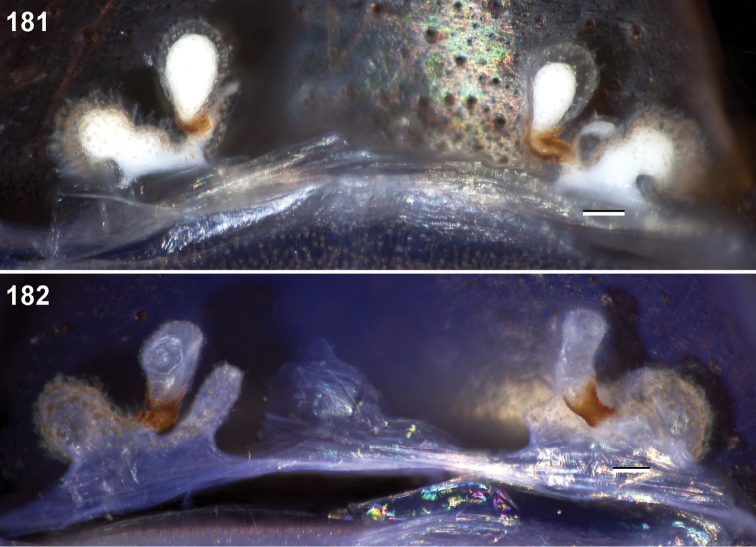
Aptostichus barackobamai sp. n. cleared spermathecae; scale bars = 0.1mm. 181 paratype from Mendocino Co. (MY3158) [806709] 182 from Sutter Co. (AP285) [806712].